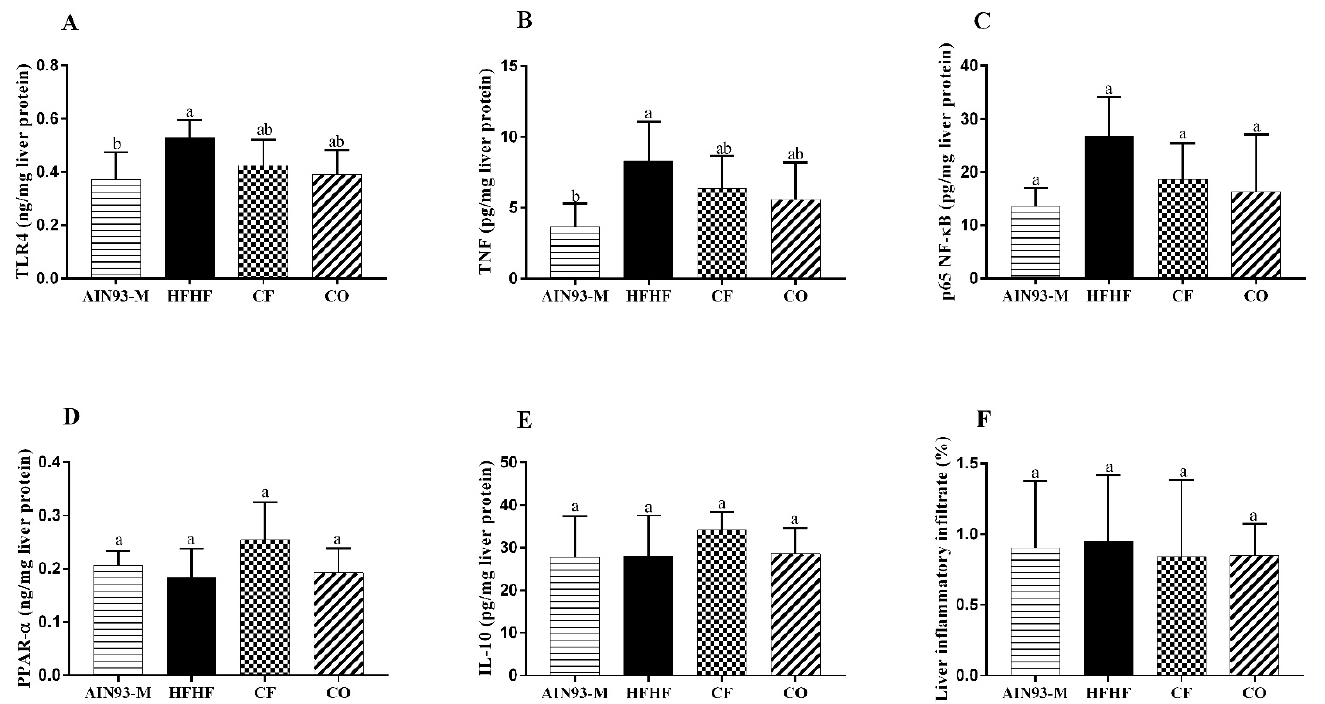
Figure 5. Effect of diets on inflammatory proteins and infiltrate in the liver at the end of 10 weeks. ( A ) Toll-like receptor 4 (TLR4); ( B ) tumor necrosis factor (TNF); ( C ) p65-nuclear factor kappa B transcriptional (NF- κ B); ( D ) peroxisome proliferator-activated receptor alpha (PPAR- α ); ( E ) interleukin 10 (IL-10); ( F ) liver inflammatory infiltrate. The animals were fed diets: AIN93-M: standard rodent diet; HFHF: high-fat and high-fructose; chia flour (CF): HFHF with 4% of soybean oil replaced by chia flour lipid (14.7% of chia flour); and chia oil (CO): HFHF diet with 4% of soybean oil replaced by 4% of chia oil for 10 weeks. Values are represented by average and standard deviation ( n = 10). The difference between the averages was analyzed by the one-way ANOVA test followed by the Newman–Keuls post-hoc test. Different letters indicate significant statistic difference ( p < 0.05).